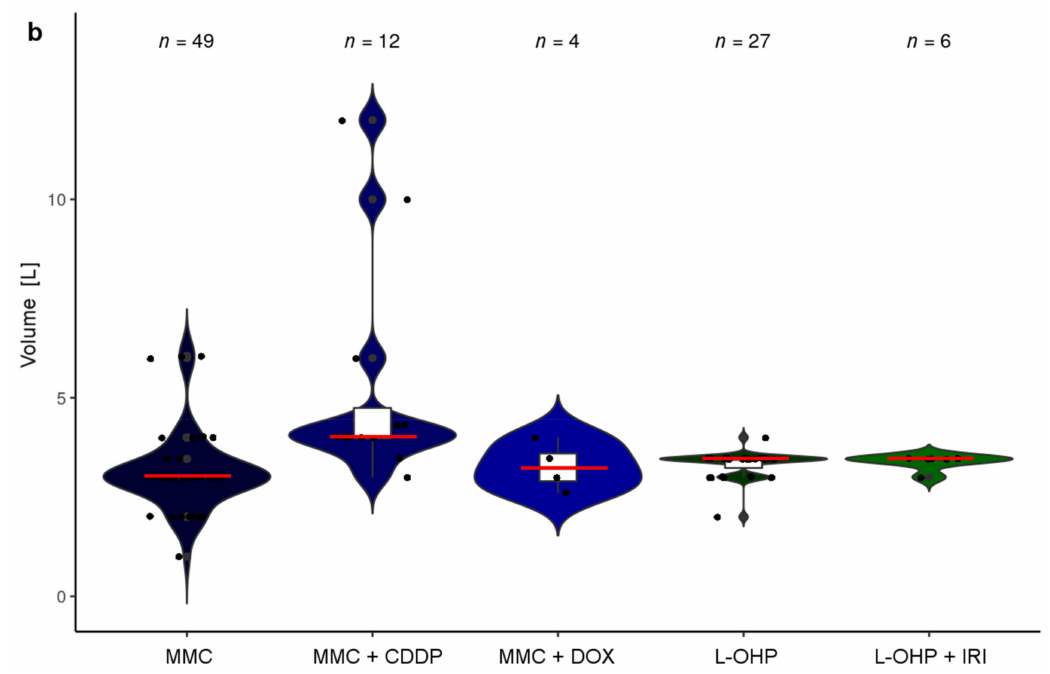
Figure 11. Overview on drug diluent volumes: The violin plots depict volumes of solutions used to dilute drugs employed for HIPEC with protocols categorized according to ( a ) solvent characteristics or ( b ) drugs used for HIPEC (reported volumes of ≤ 0.5 L were omitted). (Median volumes (L): crystalloid: 3.0; Dextrose: 3.5; PDS: 3.0; NR: 4.0/MMC: 3.0; MMC + CDDP: 4.0; MMC + DOX: 3.2; L-OHP: 3.5; and L-OHP + IRI: 3.5). The red bars mark medians and white boxes interquartile range. Abbreviations used: CDDP (cisplatin); DOX (doxorubicin); IRI (irinotecan); MMC (mitomycin c); PDS (peritoneal dialysis solution); L-OHP (oxaliplatin); and NR (not